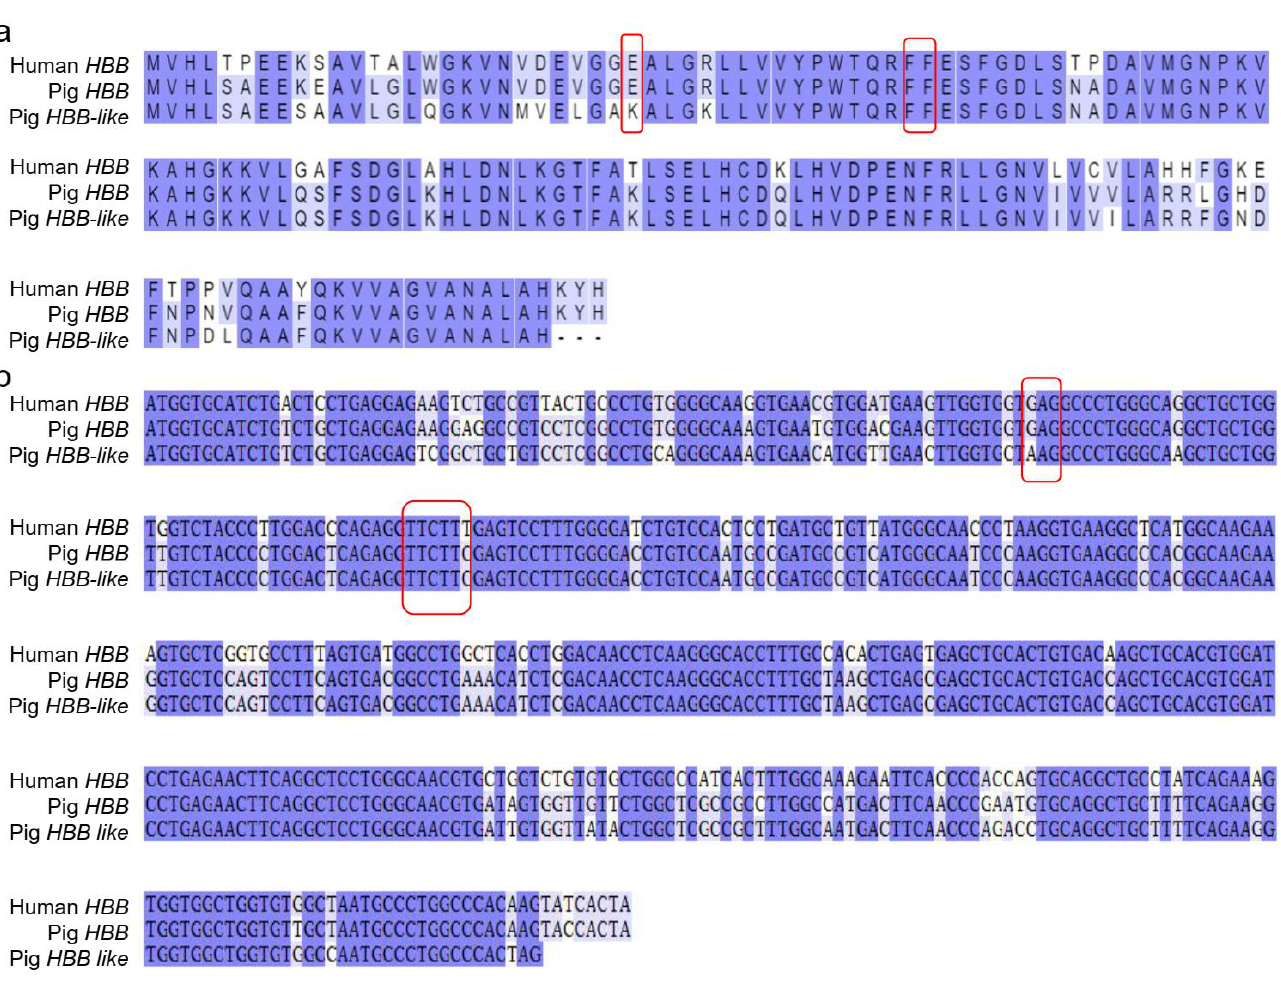
Figure 2. Sequence alignment of human HBB gene, pig HBB gene and pig HBB-like gene. ( a ) Sequence alignment of human HBB , pig HBB and HBB-like proteins; ( b ) The CDS sequence alignment of human HBB gene, pig HBB gene and pig HBB-like gene.